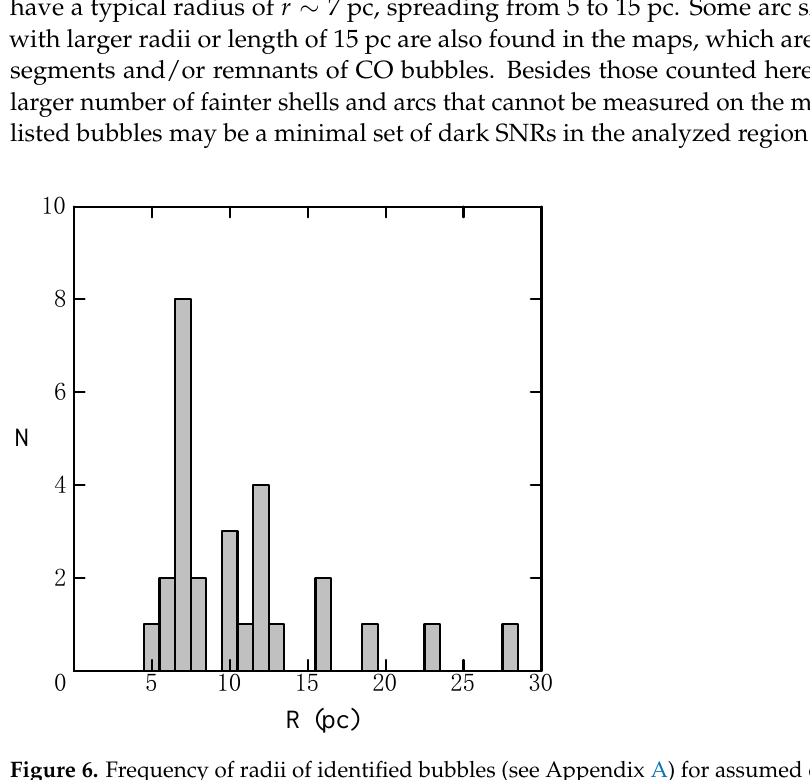
Figure 6. Frequency of radii of identified bubbles (see Appendix A) for assumed distance of 5.5 kpc to